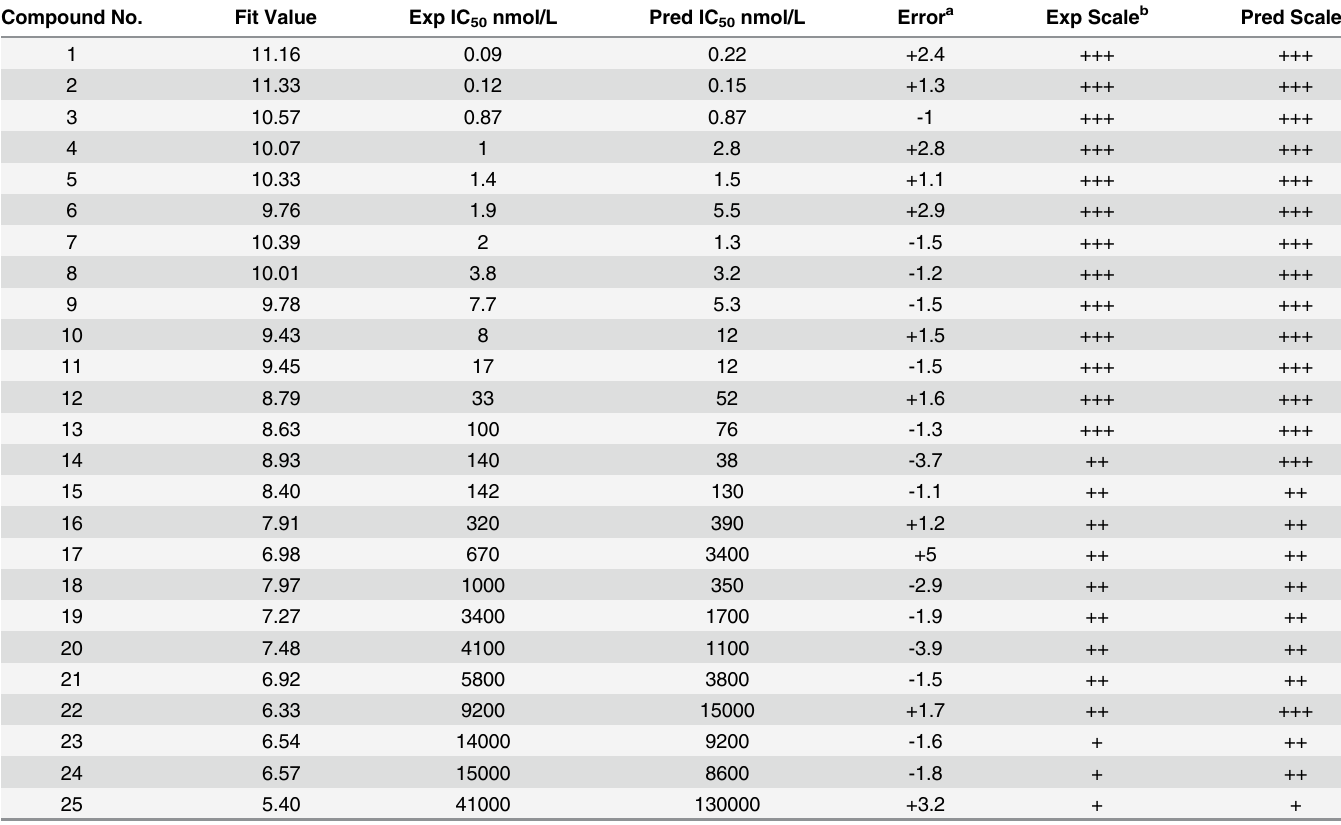
Table 2. Experimental and estimated activity of training set compounds based on Hypo 1. Compound No.